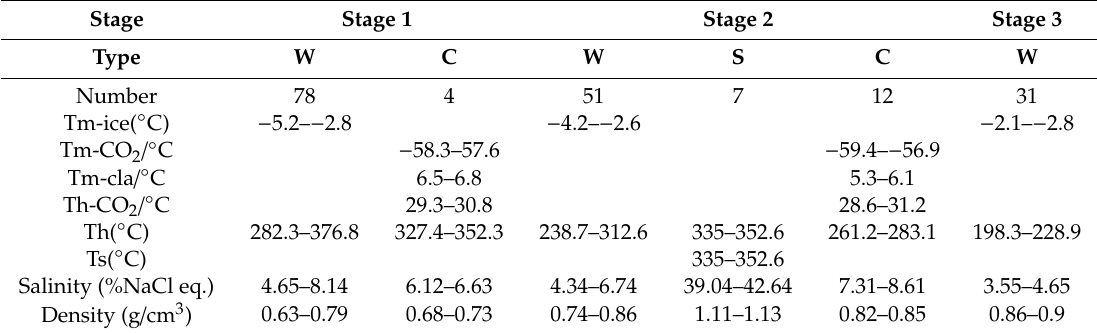
Table 1. Microthermometric data of fluid inclusions from the Reshui Mo deposit.